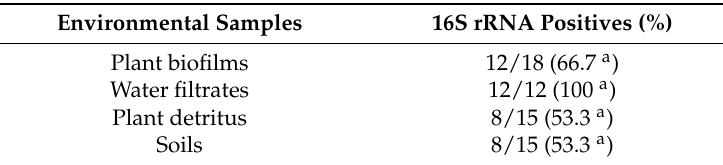
Table 2. Distribution of mycobacteria in aquatic environmental matrices from Adiopodoumé.